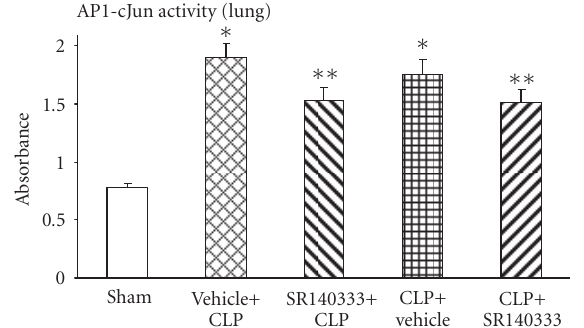
Figure 2: E ff ect of SR140333 administration, either 30 minutes before or 1 hour after CLP, on lung AP-1 activity. Results shown are the mean ± S.E.M ( n = 8-9 in each group). “Vehicle + CLP” and “SR140333 + CLP” represent the groups that received vehicle and SR140333 treatment, respectively, commencing 30 minutes prior to CLP. “CLP + vehicle” and “CLP + SR140333” represent the groups that received vehicle and SR140333 treatment, respectively, 1 hour after CLP. ∗ P < . 001 when vehicle-treated CLP animals were compared with sham group animals; ∗∗ P < . 05 when SR140333-treated CLP animals were compared with vehicle-treated CLP animals. AP-1: activator protein-1; CLP: cecal ligation and